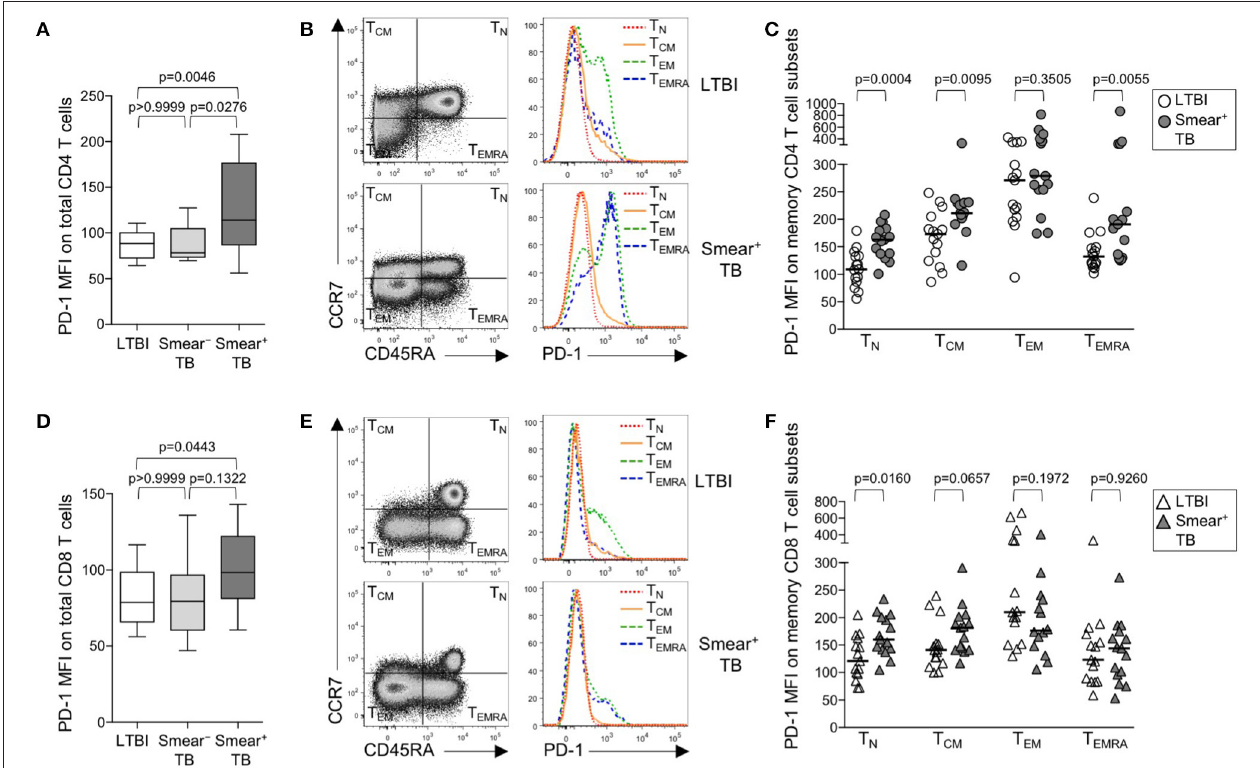
FIGURE 1 | PD-1 is upregulated on naïve and memory CD4T cell subsets in patients with smear + TB disease. PD-1 expression was measured by flow cytometry using whole blood samples obtained from individuals with LTBI ( n = 33), and patients with smear − TB ( n = 12) and with smear + TB ( n = 29). The MFI of PD-1 expression is shown on the total CD4T cell population (A) and the total CD8T cell population (D) . PD-1 expression on naïve and memory CD4 and CD8T cell subsets was performed on a subset of individuals with LTBI ( n = 15) and patients with smear + TB ( n = 15). Representative flow cytometry data are shown of the naïve and memory T cell profile of CD4T cells (B) and CD8T cells (E) from an individual with LTBI (top row) and a patient with smear + TB (bottom row). The flow cytometry data in (B) are gated on viable CD3 + CD4 + lymphocytes; the flow cytometry data shown in (E) are gated on viable CD3 + CD8 + lymphocytes. T N , T CM , T EM , and T EMRA subsets are indicated in each quadrant, according to expression of CCR7 and CD45RA. A histogram overlay of PD-1 expression by each T cell subset (T N , T CM , T EM , and T EMRA ) is shown on the right. Composite data are shown indicating PD-1 MFI on naïve and memory CD4 (C) and CD8T cell subsets (F) . Horizontal lines represent the median. Differences between the three groups in (A, D) were assessed using a Kruskal-Wallis test; the p -values shown have been adjusted for